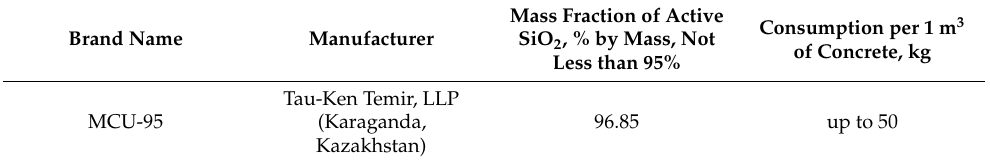
Table 6. Characteristics of microsilica [23].